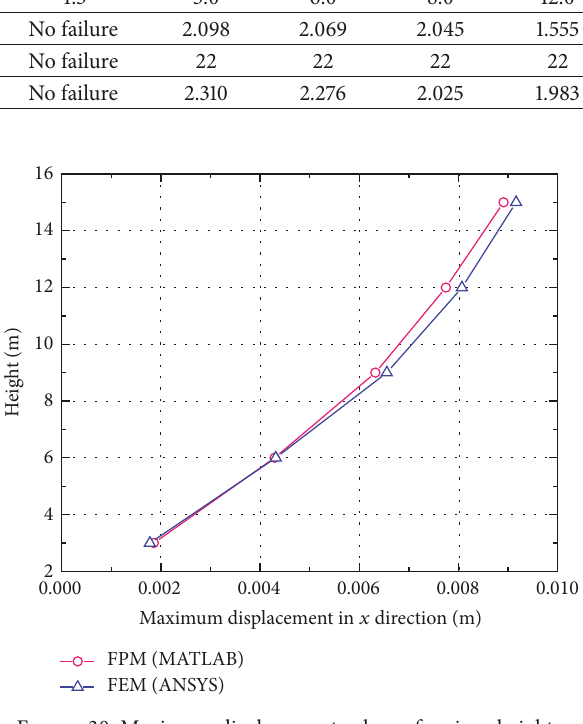
Figure 30: Maximum displacement values of various